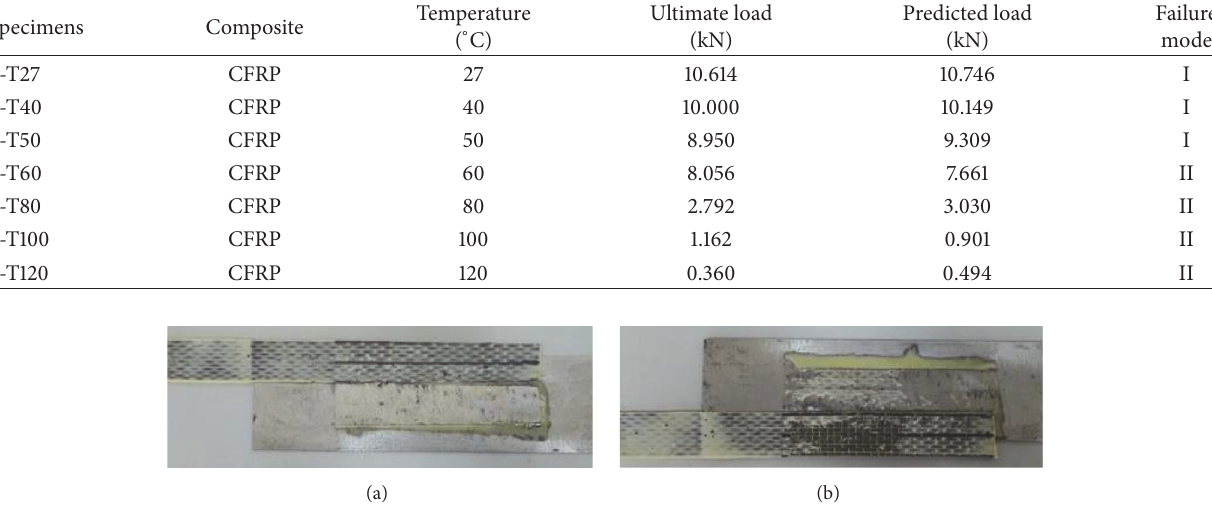
Figure 4: Typical failure modes: (a) Mode I; (b) Mode II.